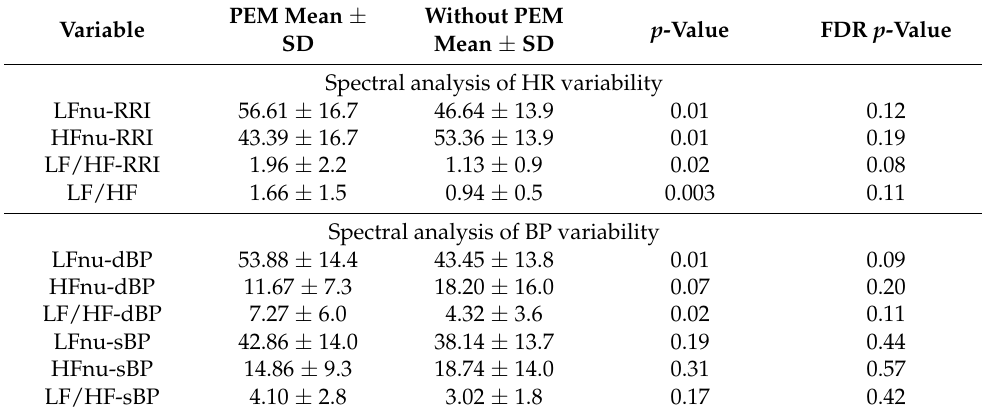
Table 3. Comparison of autonomic parameters in patients with PEM and without PEM.